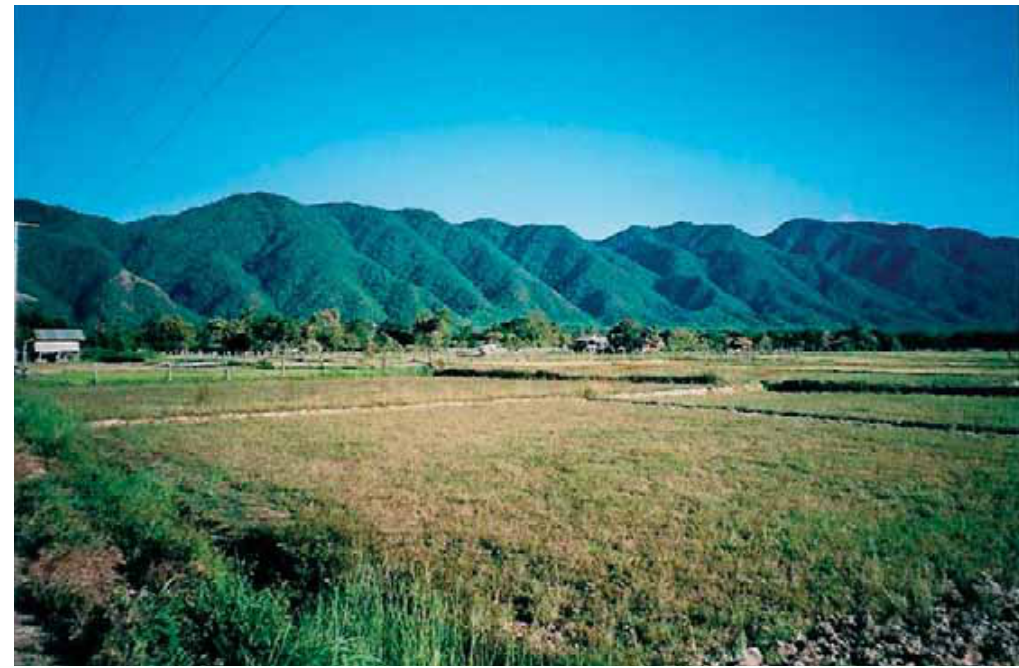
Fig. 6. Triangular faceted spurs along the Thoen Fault escarpment east of Ban San Pa Pao. Note the oversteepened base and the development of several erosional benches along the